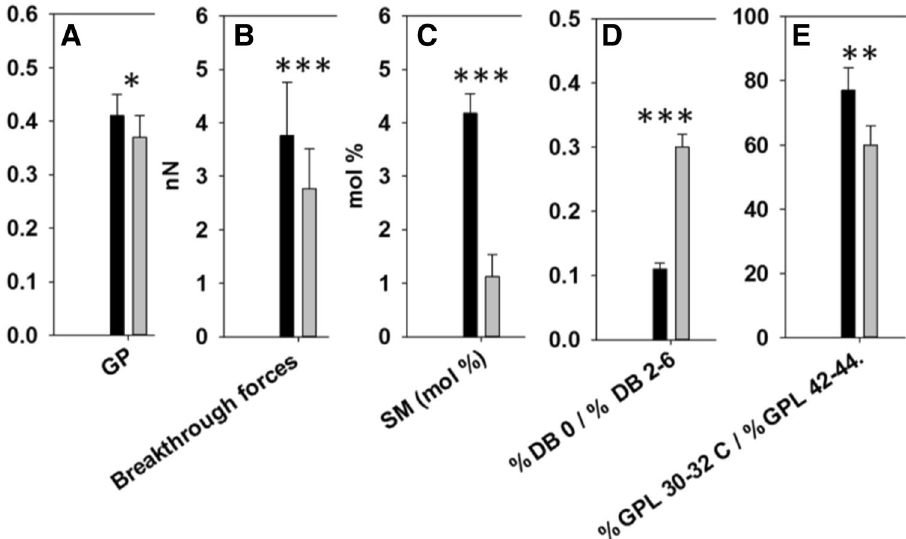
Figure 8. A correlative presentation of myriocin effects on the plasma membranes of CHO cells grown on SL-deficient medium. Black bars: control, non-myriocin treated cells; grey bars: myriocin-treated cells. ( A ) Laurdan general polarization in PM patches (data from Fig. 4). ( B ) Bilayer breakthrough forces obtained by AFM in the force-spectroscopy mode (data from Fig. 6). ( C ) Mole percent SM contents in PM patches (data from Table S1 and Fig. 7A). ( D ) Saturated/unsaturated fatty-acyl mole ratio (data from Table S1 and Fig. 7D, E). ( E ) Short-chain/very-long-chain fatty-acyl mole ratio (data from Table S1 and Fig. 7 F, H). Significance (control vs. myriocin-treated cells) according to Student’s t-test: * P < 0.05; ** P < 0.01, *** P <